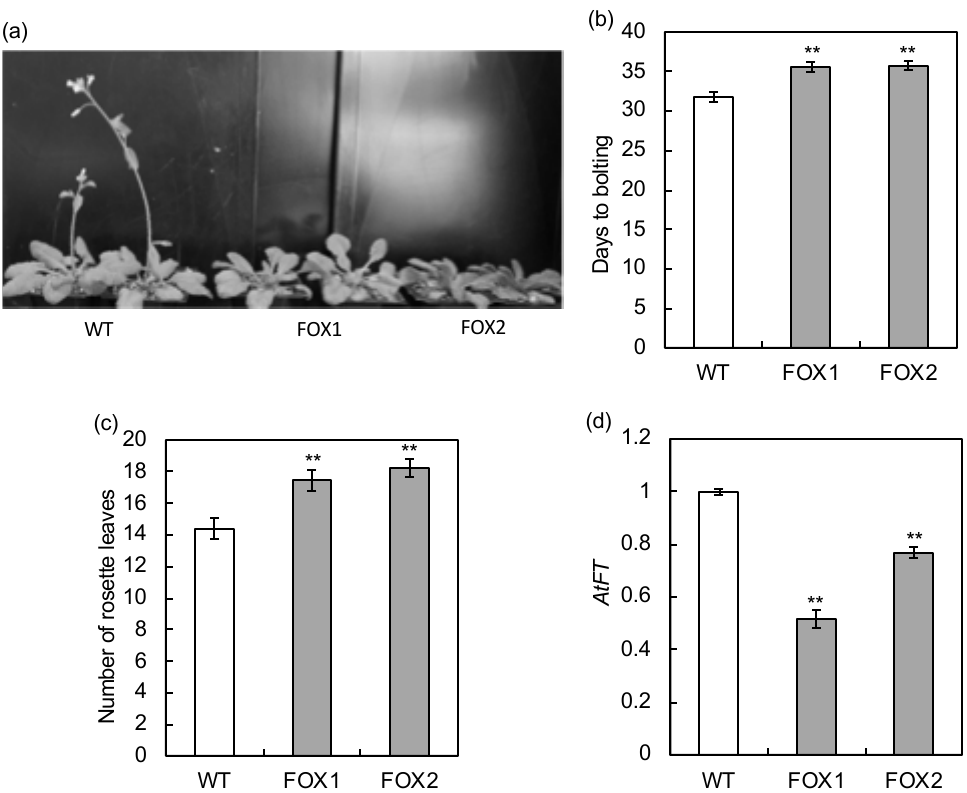
Figure 5. The overexpression of MdFLC3 and phenotypic analysis in Arabidopsis . Flowering phenotypes 32 days after sowing ( a ), days to bolting from sowing ( b ), the number of rosette leaves at bolting time ( c ), and the expression levels of AtFT ( d ) in the MdFLC3 transgenic (FOX1, 2) and wild-type (WT) plants grown under a 16 h photoperiod. The values with ** significantly di ff ered between FOX and WT plants at p < 0.01, according to the Dunnett test. The values in ( b , c ) indicate means and standard errors (n = 30 or 31). The relative expression of AtFT was determined from triplicate measurements of three independent biological replicates 15 days after sowing ( d ). The relative expression levels were normalized against AtACTIN with standard errors and the maximum level of the transcripts was set at